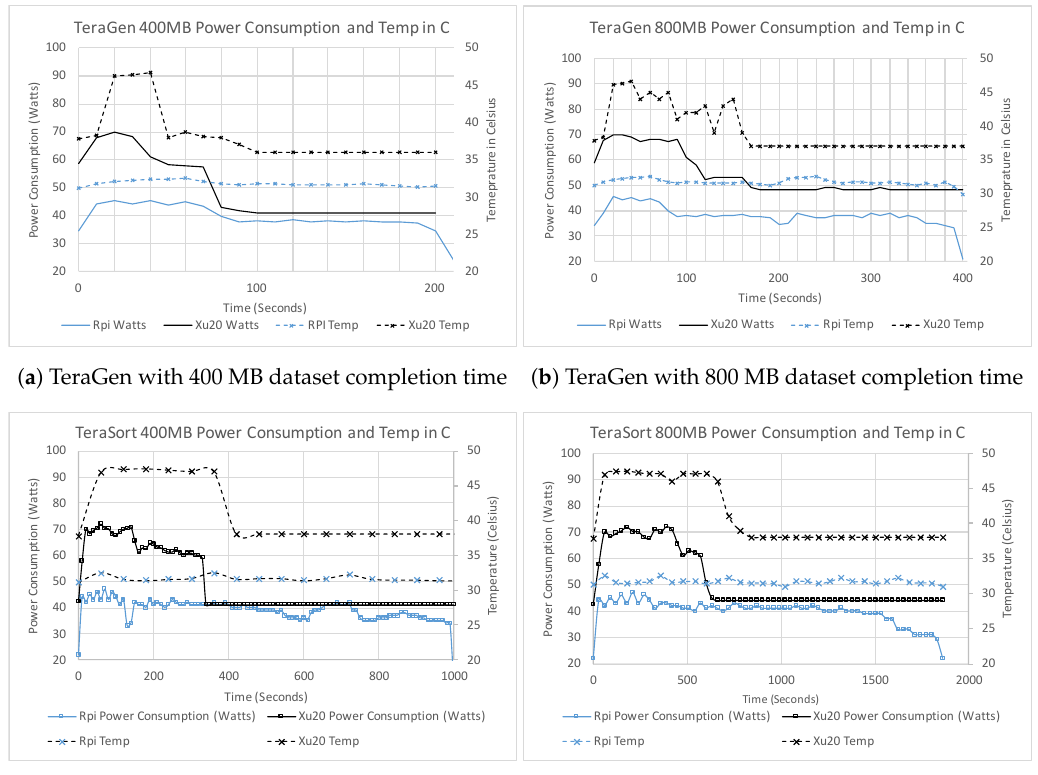
Figure 6. Power Consumption (Watts) and Temperatures (Celsius) for RPi and Xu20 Clusters.